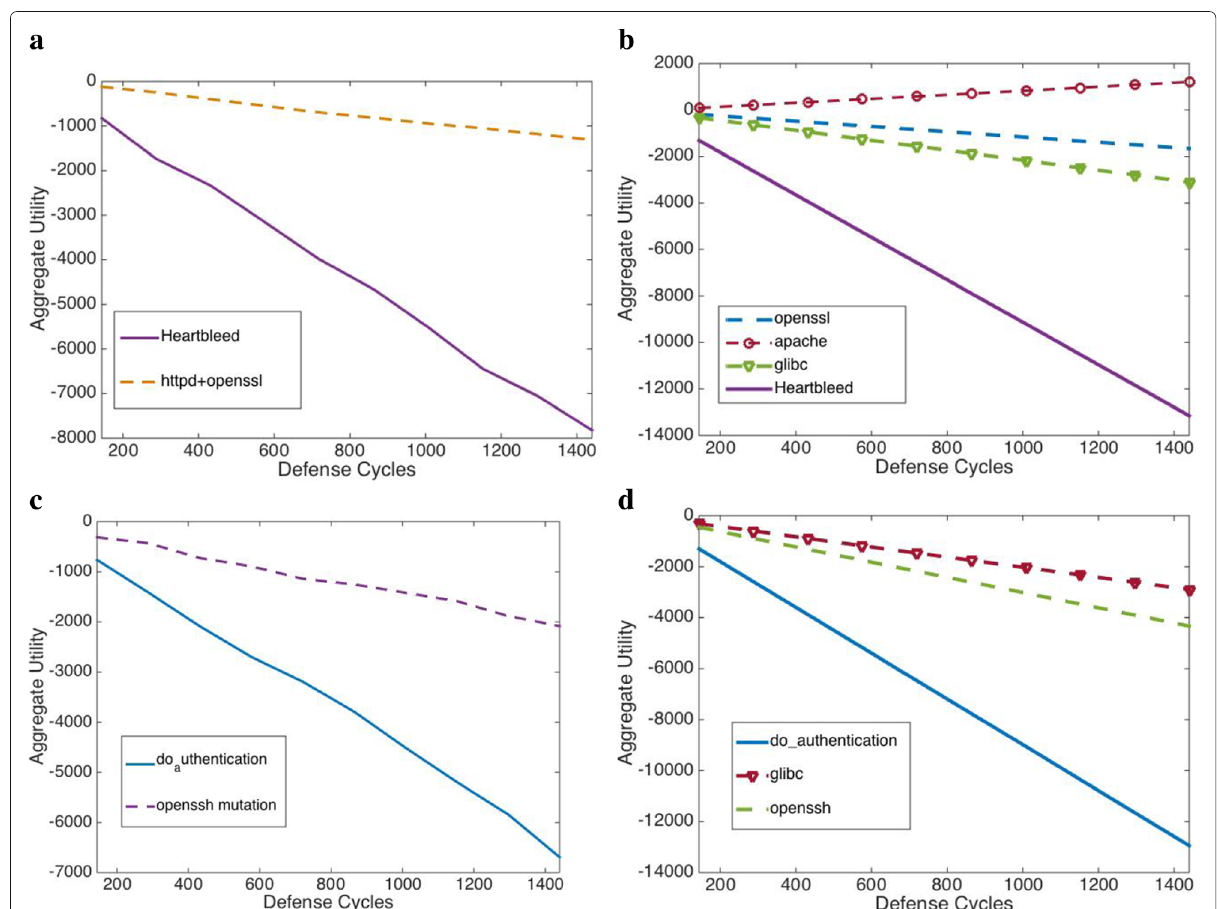
Fig. 5 a - b Compare the aggregate utility values of apache + openssl (CVE-2002-0656 & CVE-1999-0071), and Heartbleed (CVE-2014-0610) in real server experiments with the aggregate utility values in Matlab simulations; c - d compare the aggregate utility values of openssh mutation (CVE-2001-0144) and do_authentication (CVE-2001-0144) in real server experiments with the aggregate utility values in Matlab simulations